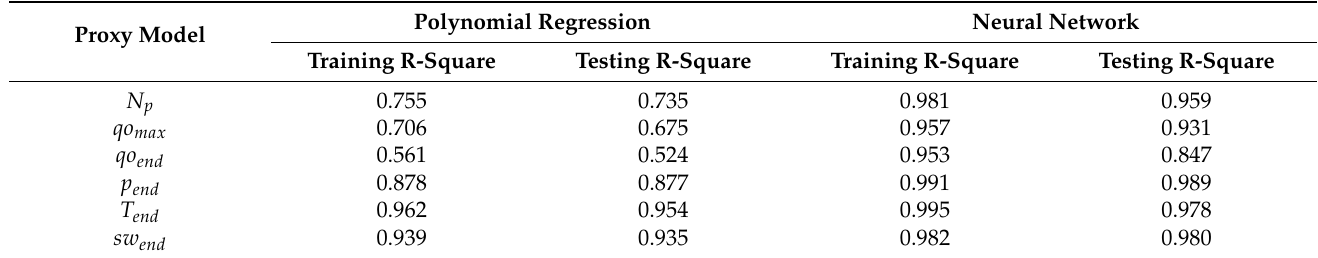
Table 4. Summary of training and testing R-square values for each proxy model.